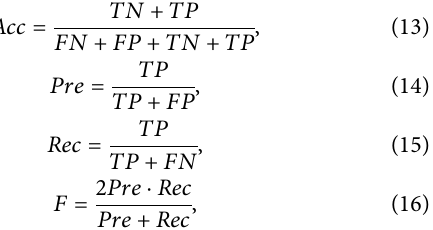
XGBoost (Chen and Guestrin, 2016) was used to create